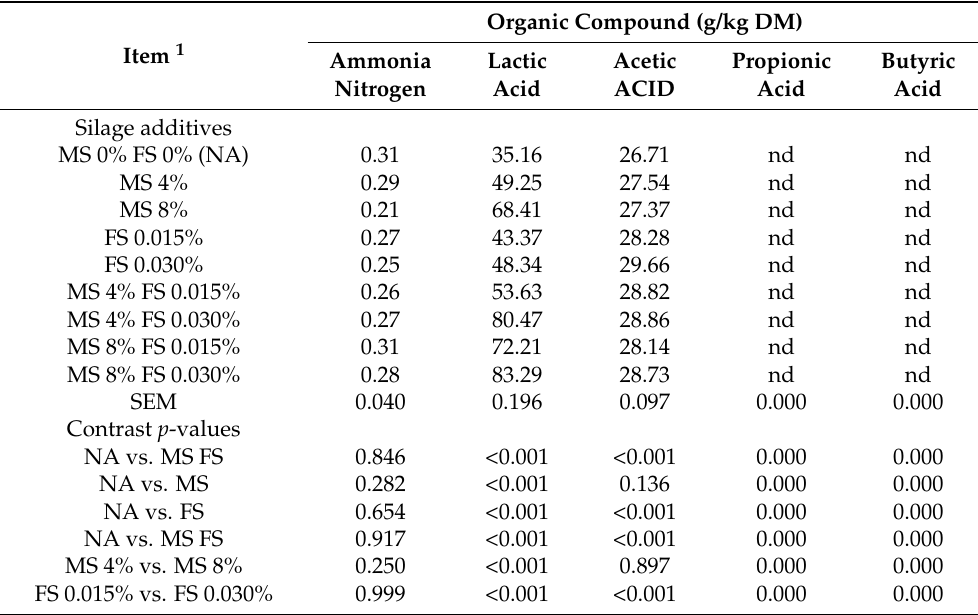
Table 4. Fermentative quality of anthocyanin-rich black cane prior to ensiling (pre-ensiled materials) and its silages at 42 d after fermentation.